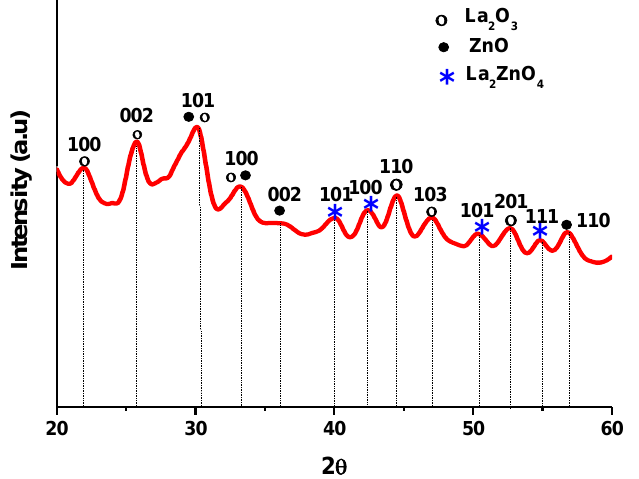
Figure 1. X-ray diffraction spectrum of La 2 ZnO 4 .